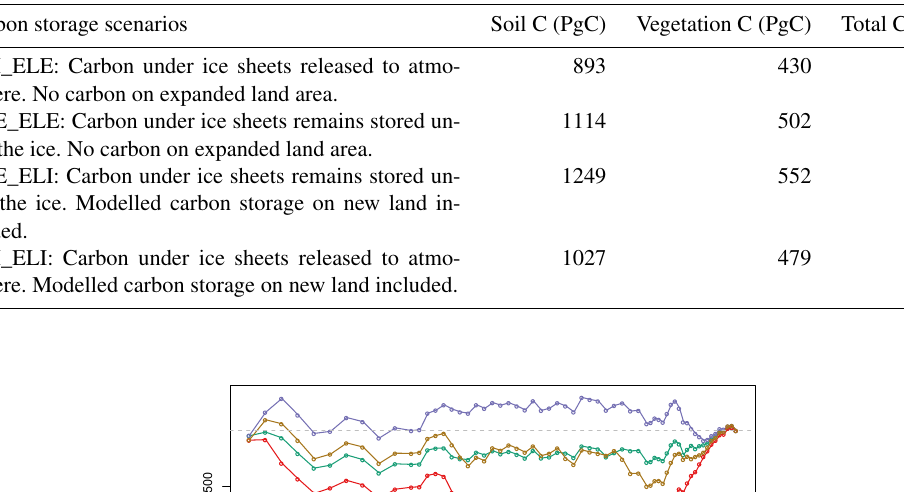
Table A1. Terrestrial carbon storage at the LGM.